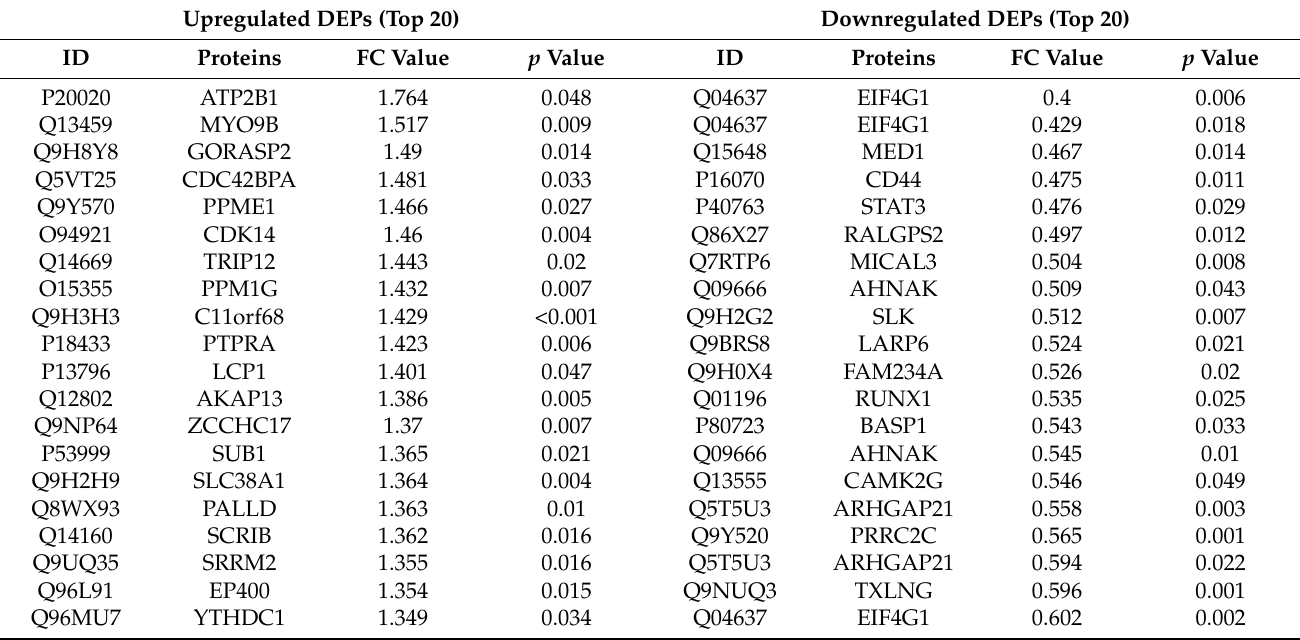
Table 1. Top 20 differentially expressed phosphoproteins